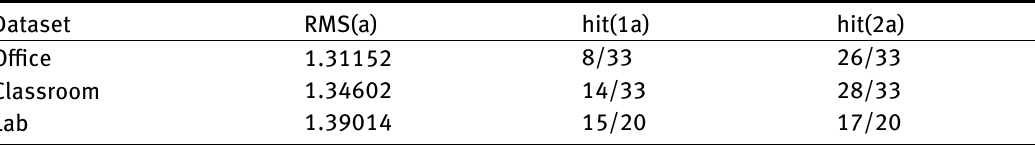
Table 1: The RMS of experience based localization experiment.